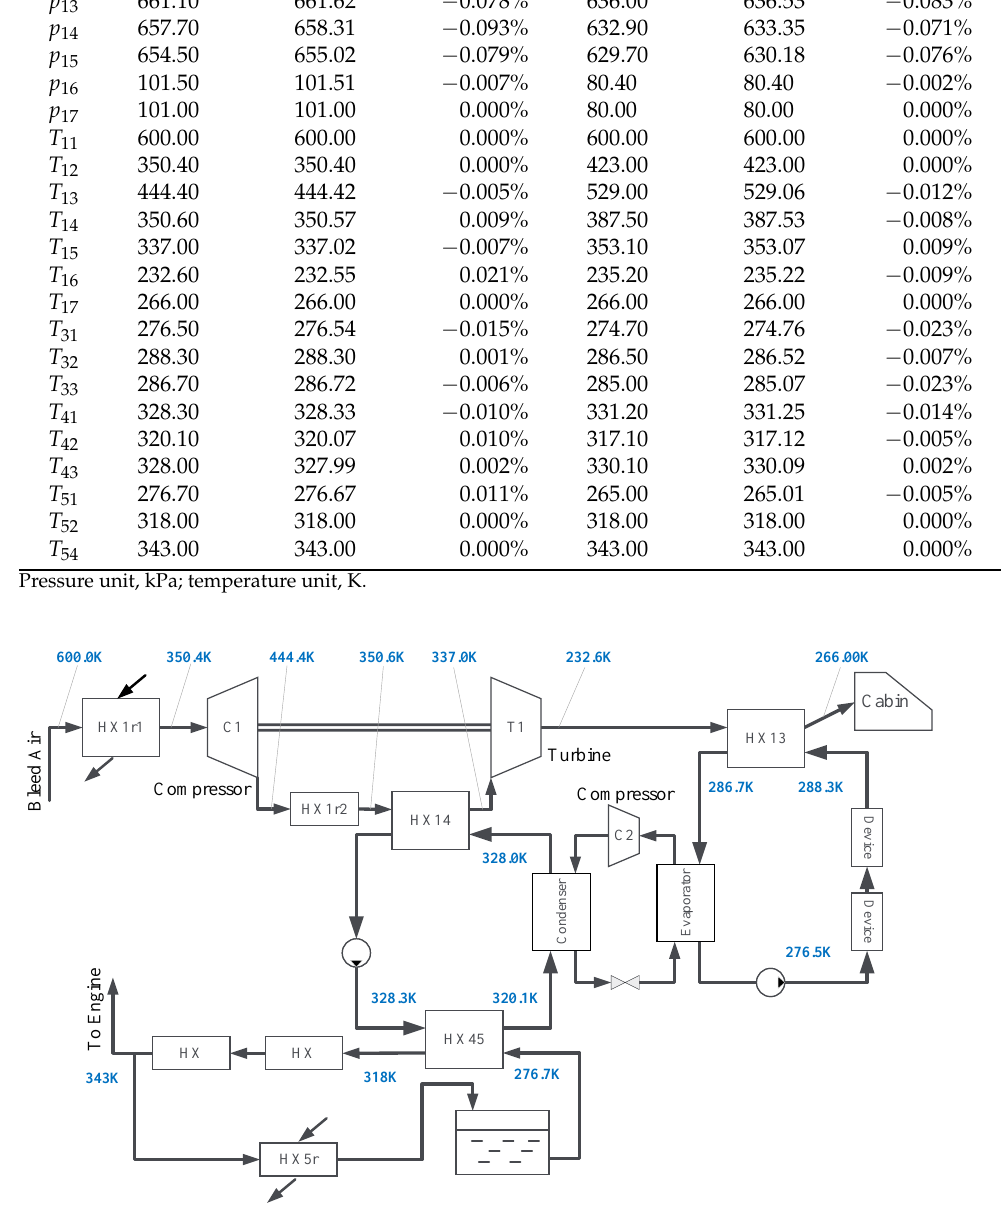
Figure 5. Temperature results under ground